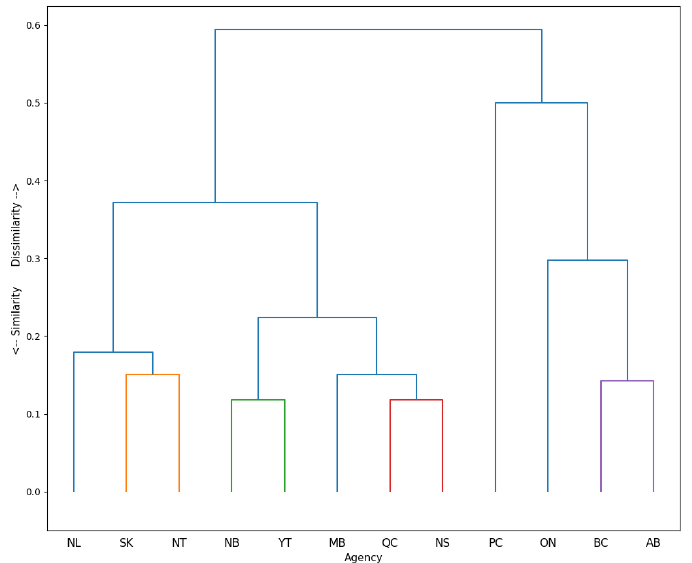
Figure 7. Dendrogram illustrating fire management agencies in similar clusters considering only indicators from agency partnerships in delivery and development. We see that QC and NS merge first (in red), next, NB and YT (in green), BC and AB (in purple), SK and NT (in orange), and so forth.